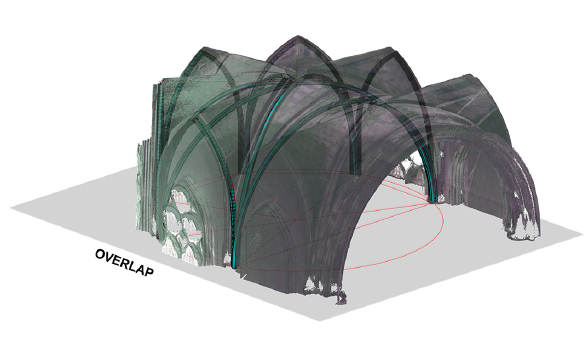
Figure 18 .Church of Donnaregina apses vault: overlap ideal model on point cloud